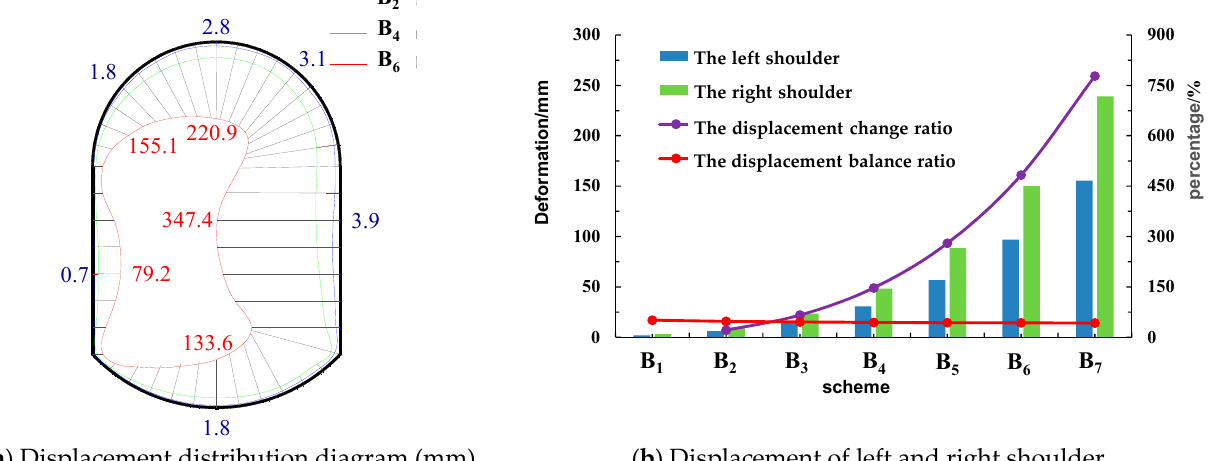
Figure 8. Displacement analysis of different section sizes. ( a ) Displacement distribution diagram ( b ) Displacement of left and right shoulder.